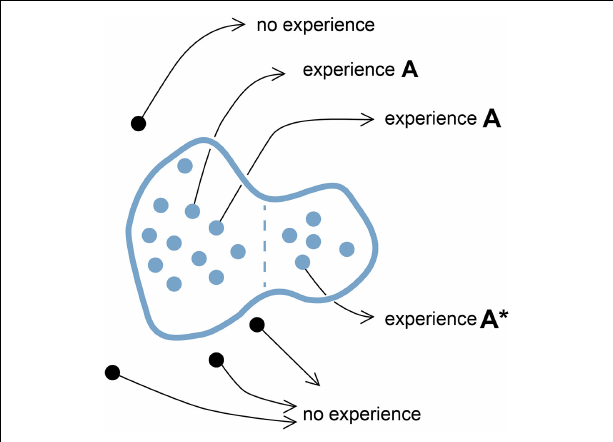
FIGURE 1 | A point cloud in SC-space. The diagram represents a configuration space where distance measures incremental differences in the way a related set of neural circuits (variants) can be configured or, for the case of neural events, incremental differences in variables chosen to represent those events. Each point within the domain bounded in blue represents a selector circuit (SC), defined as a neural circuit or neural event that acts to evoke a particular experiential quale (the A s in this case). Black points outside the domain represent circuit or event variants that fail to evoke that quale, or in this case, any experience at all. For an individual brain, the quale in question could theoretically be evoked by many SCs acting in concert, represented here by a point cloud, or few, or only one. Individual brains could thus vary both quantitatively (how many variants are active and effective) and qualitatively (how tightly clustered they are in SC-space). Experience A * is included to indicate that there may be differences in the experience evoked at different points within the domain, i.e., that experience A * may be qualitatively different than A . For example, the domain as a whole might include SCs for both fear ( A ) and panic ( A *), so a point cloud clustered predominantly on the left would evoke fear, on the right, panic, or both feelings together if the SCs are evenly distributed. How gradual the transition might be from fear to panic along trajectories in SC-space is not specified, nor how abruptly either experience is degraded for SCs located near the domain boundary, which could for that reason be “fuzzier” than shown here. The domain could also be more cloud-like in being diffuse and full of holes representing SCs inside the domain that happen not to produce an experience. Indeed, the term point cloud would typically be employed topologically to refer to the domain itself, so as to include the total set of all possible SCs of a specified type, but is here used in a more restricted sense, to refer to only those SCs realized in real brains at either the individual or population level. The diagram is highly schematic in reducing the high-dimensional space required to represent the complexities of real neural circuits and events to a two-dimensional surface, and is intended to apply only to the most fundamental units of experience, i.e.,